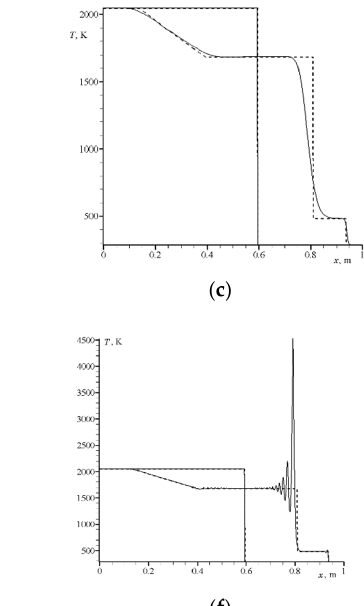
( h ) ( i ) Figure A1. Calculation results for discontinuity decay in ( ) p x , ‐ , and ( ) T x ‐ distributions at the times